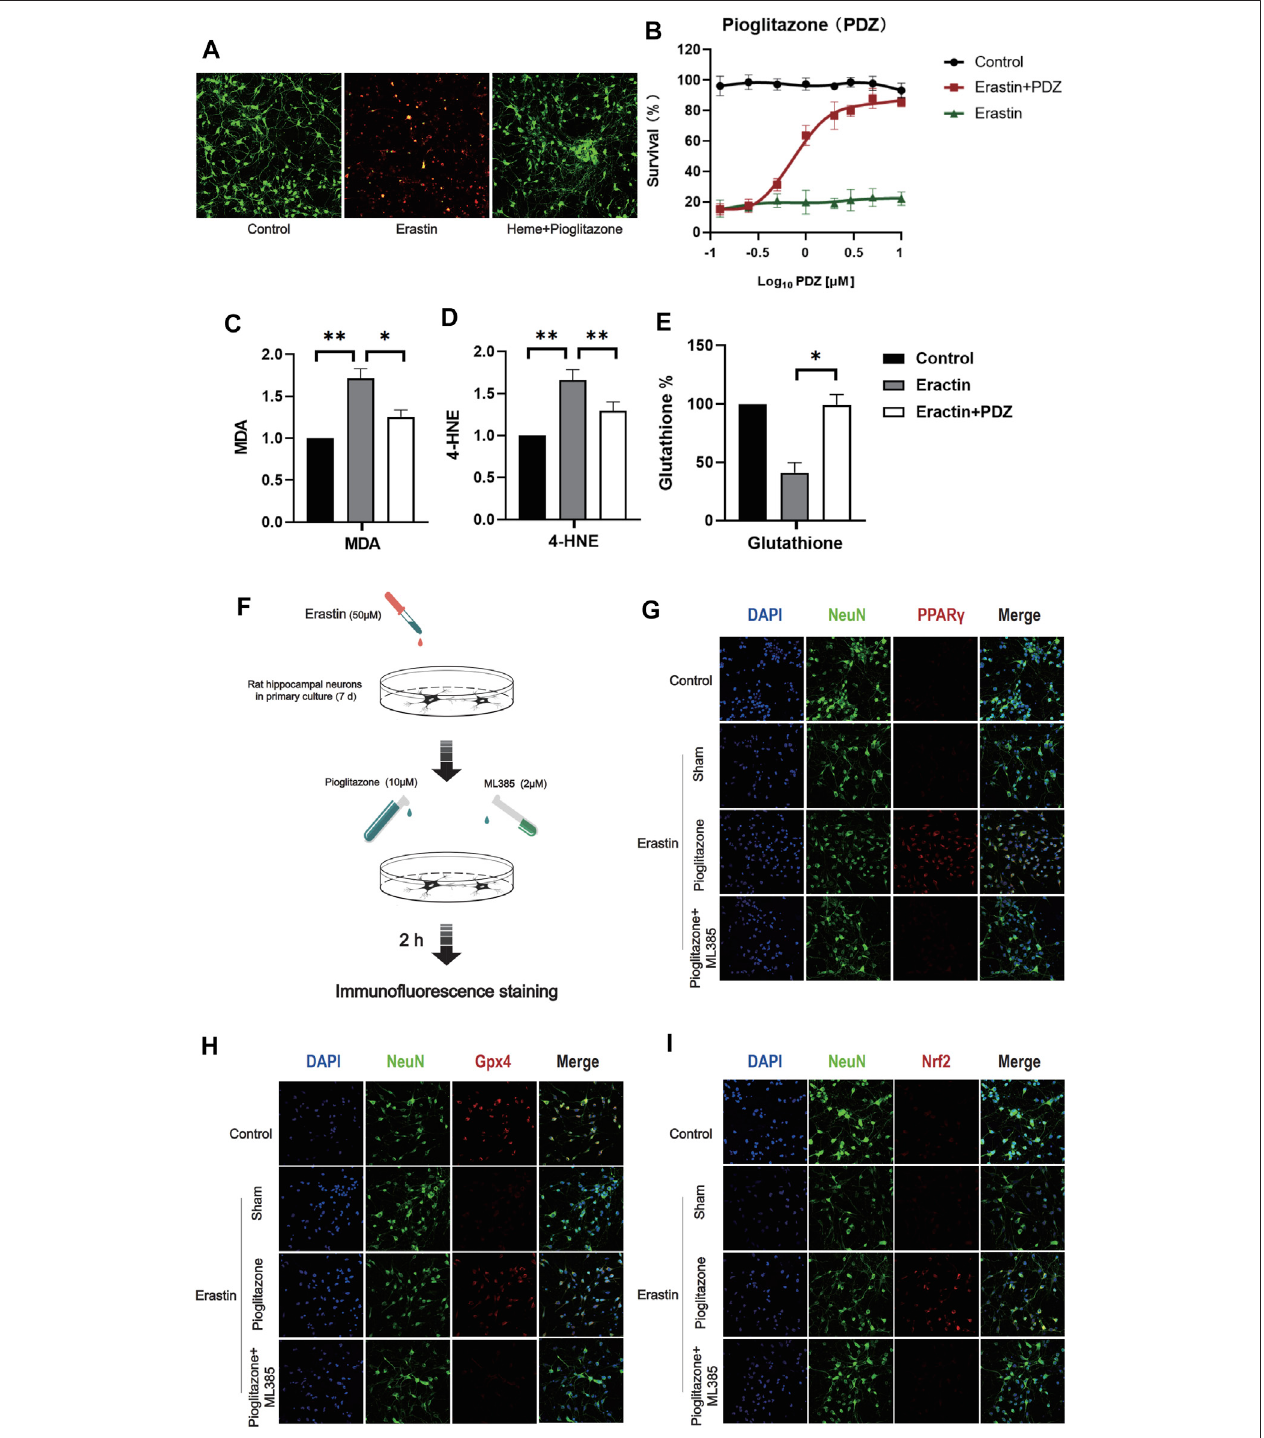
FIGURE2| PPAR γ activationinhibitsErastin-inducedneuronalferroptosis invitro byactivatingNrf2. (A) After7 daysofculture,ratprimaryhippocampalneuronsof each group were used for the cell survival/death analysis (green fl uorescent cells labeled with calcein-AM were alive, and red fl uorescent cells labeled with ethidium homodimer were dead). Then, representative images were captured using a confocal fl uorescence microscope. (B) The fl uorescence intensity of CCK-8 staining was detected at 450 mm using a microplate reader. (C) A kit was used to detect the MDA content in each group of neurons. (D) 4-Hydroxynonenal (4-HNE) content in each group of cells. (E) The reduced glutathione content in the neurons of each group was detected. (F) Immuno fl uorescence staining was used to evaluate the excitatory effect of pioglitazone on PPAR γ , Nrf2 and Gpx4, and a fl ow chart of the cell-based experiment is shown. The rat primary hippocampal neurons were